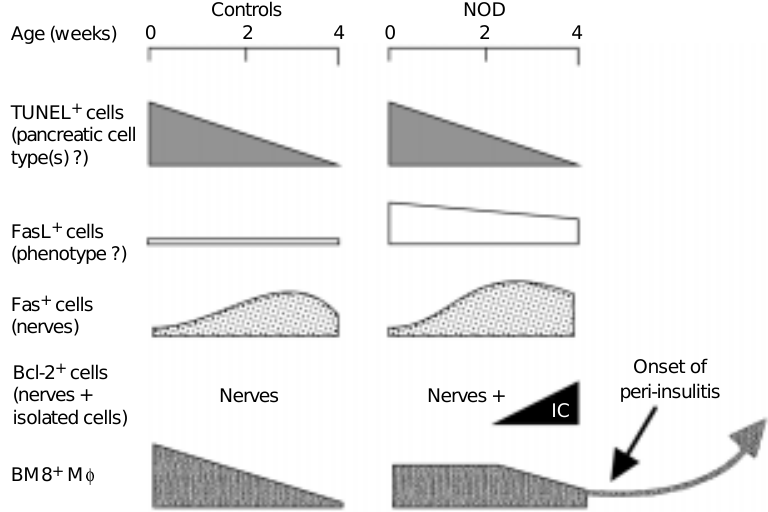
Figure 3 - Evolution of apoptosis (anti-apoptosis)-related phenomena and pancreatic BM8 + macrophage infiltration during the postnatal period in non-obese diabetic (NOD) mice. IC: Isolated cells; TUNEL: TdT-mediated dUTP-X nick end